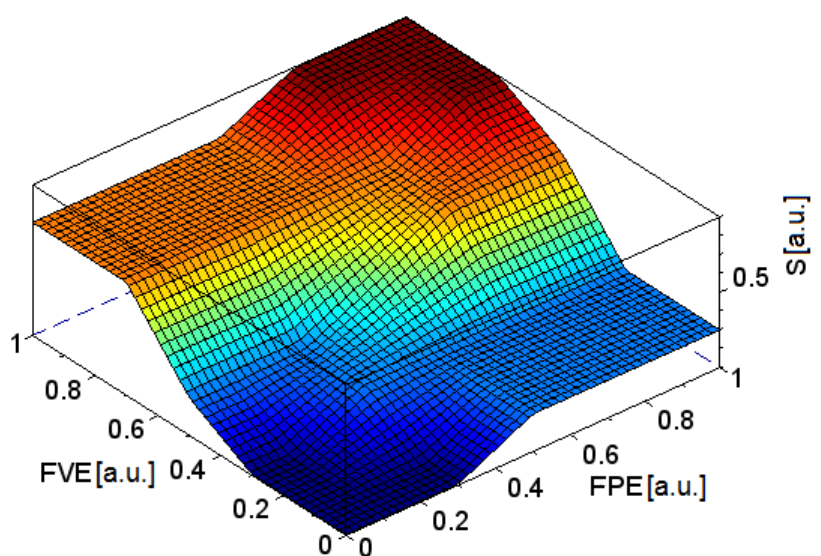
Figure 9. Output control surface of the fuzzy-logic (FL) controller developed.